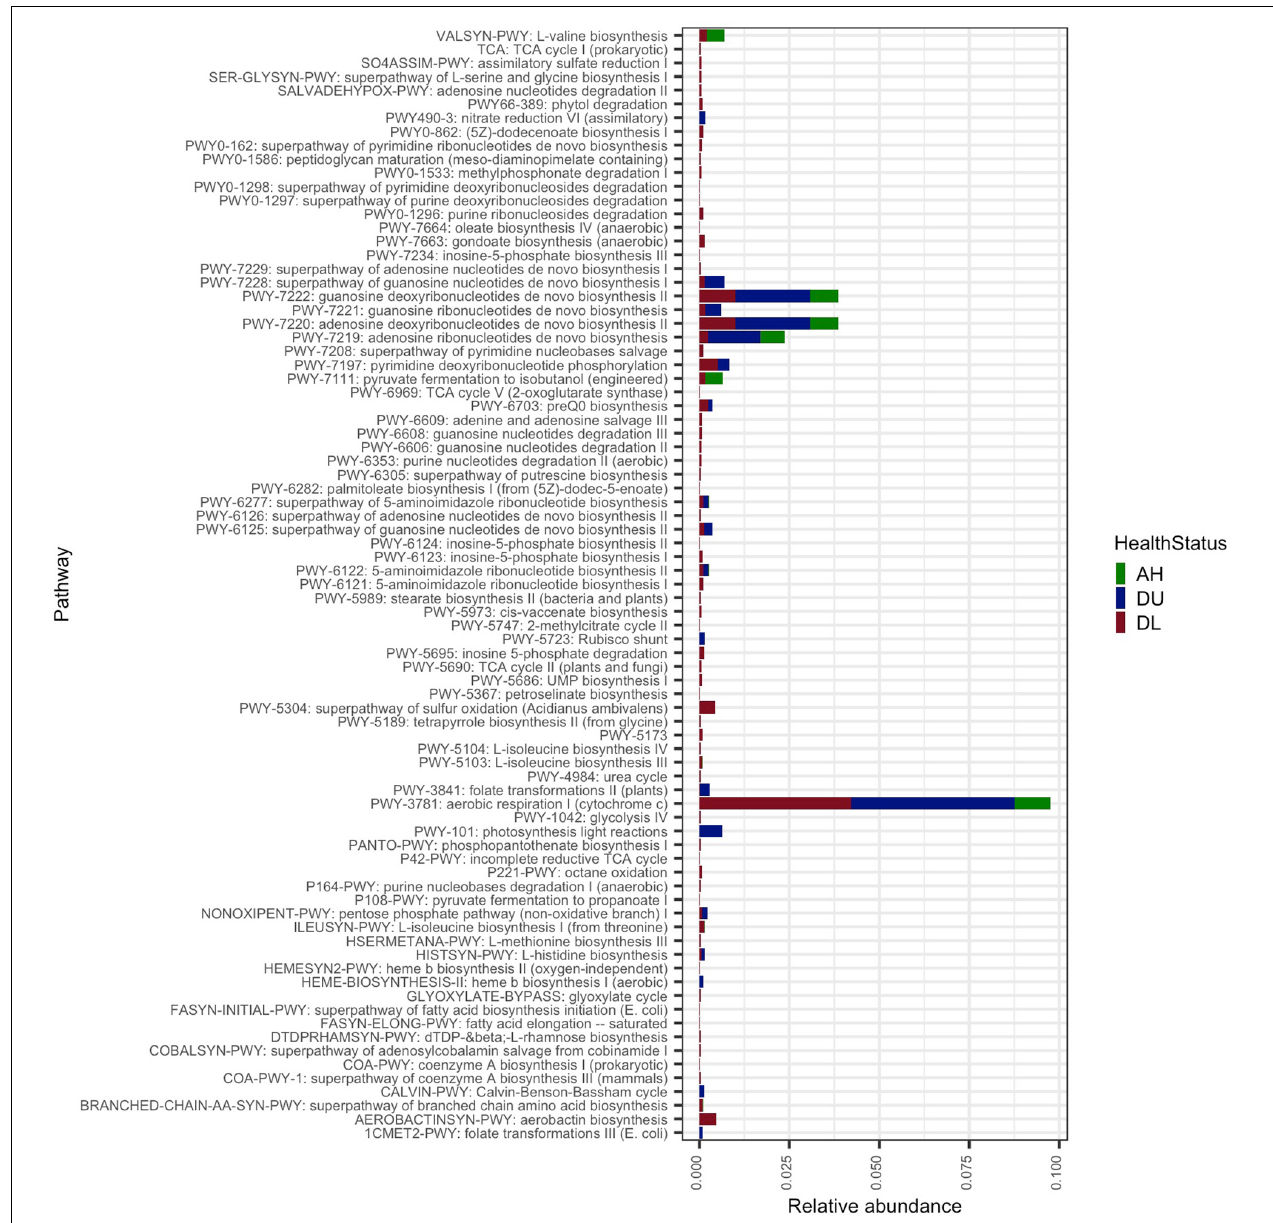
FIGURE 2 | The average relative abundance of functional pathways. All coral samples from apparently healthy colonies (AH), and unaffected (DU) and lesion (DL) tissues on diseased colonies.